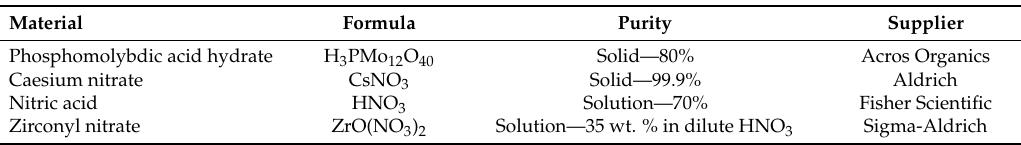
Table 1. List of reagents used for the synthesis of both caesium phosphomolybdate (CPM) and zirconium molybdate